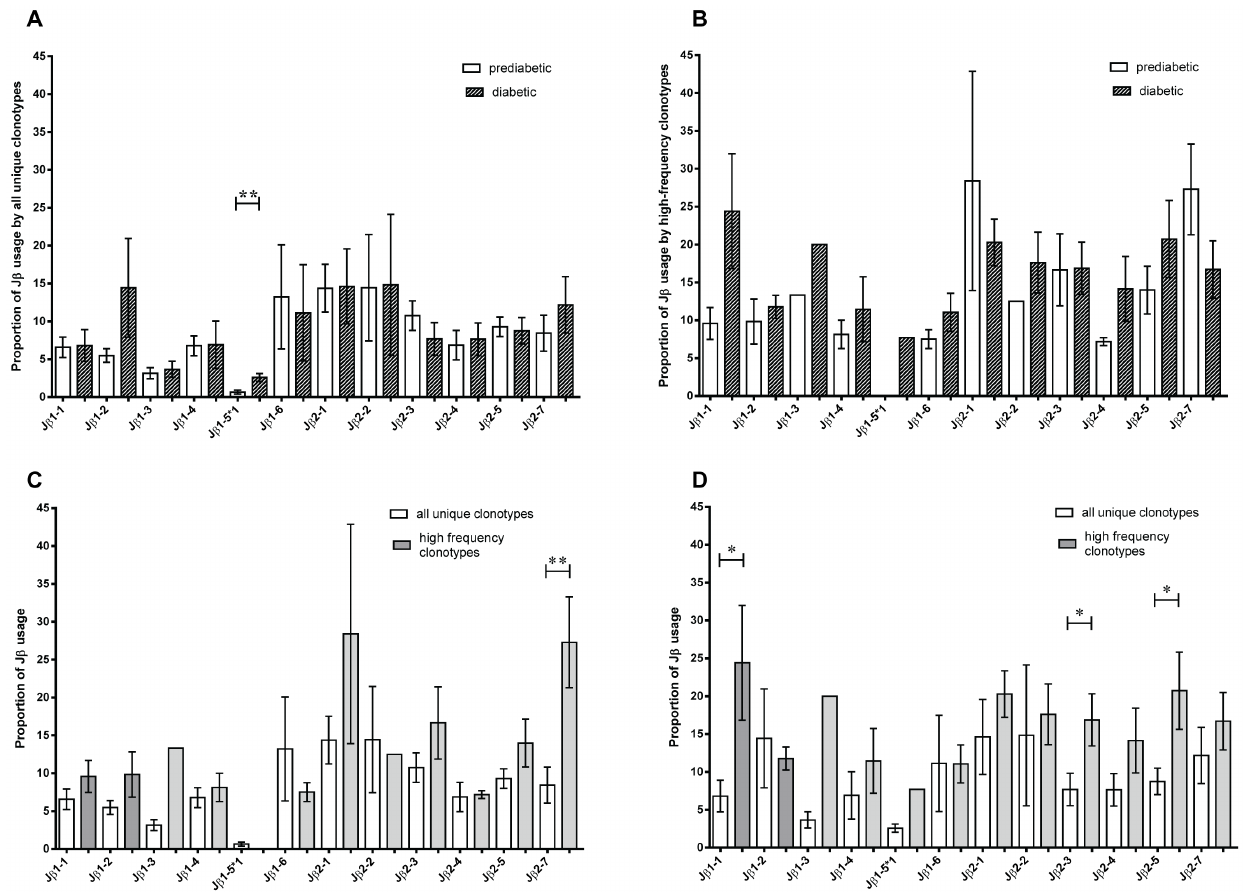
Figure 4. High variation in TRBJ usage in islet-infiltrating CD4 + CD44 high T cell clonotypes. The average frequency of TRBJ gene usage by all CD4 + CD44 high clonotypes (A) and high-frequency clonotypes (B) from prediabetic mice (**p=0.0054 for TRBJ1-5*1) and diabetic mice. The average frequency of TRBJ gene usage by all CD4 + CD44 high clonotypes and high-frequency clonotypes from (C) prediabetic mice (**p=0.0081 for TRBJ2-7) and (D) diabetic mice (*p=0.019 for TRBJ1-1, *p=0.04 for TRBJ2-3, and *p=0.022 for TRBJ2-5). All data are the mean 6 SEM.